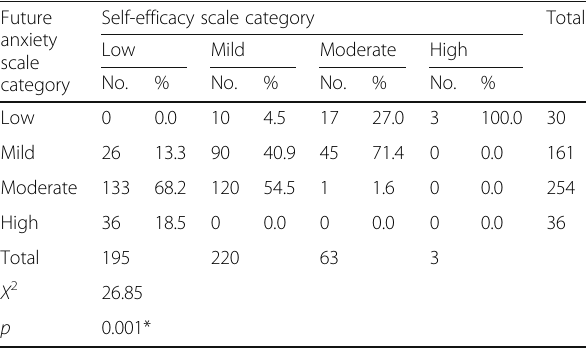
Table 4 Comparing future anxiety levels as regards self-efficacy levels Future anxiety